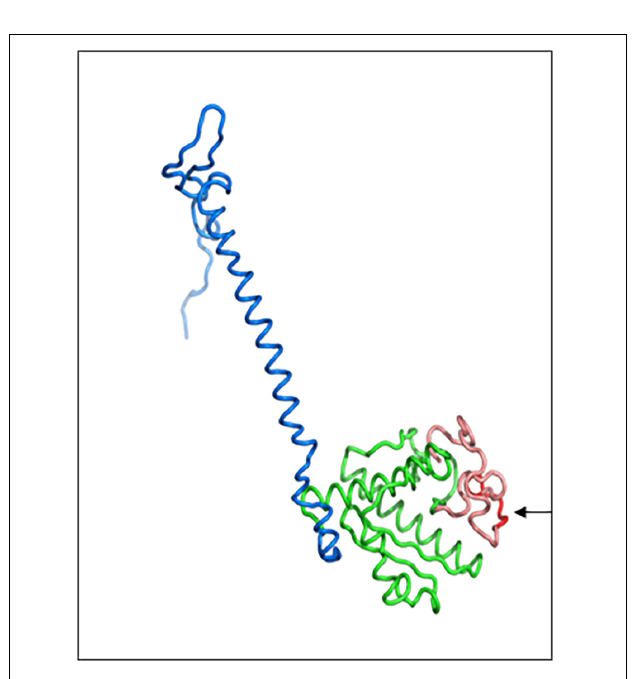
FIGURE 7 | Three dimensional structure model of PgPolyQ-MADS transcription factor. Protein model was constructed by Phyre2. The model includes the N-terminal loop (salmon) including of eight glutamine residues (polyQ, red), DNA-binding domain (green), and the C-terminal keratin-like domain (blue). Arrow points to the polyQ